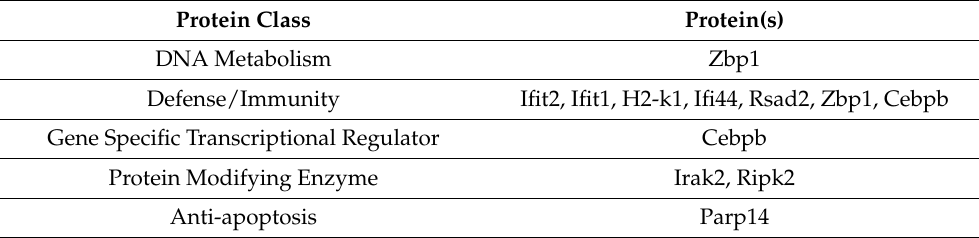
Table 2. The PANTHER/GeneCards classes of 10 of the proteins that have the highest level of upregulation compared to control at 24 h post cytomix treatment. As shown, most proteins are categorized within the defense/immunity class, followed by the protein modifying enzyme